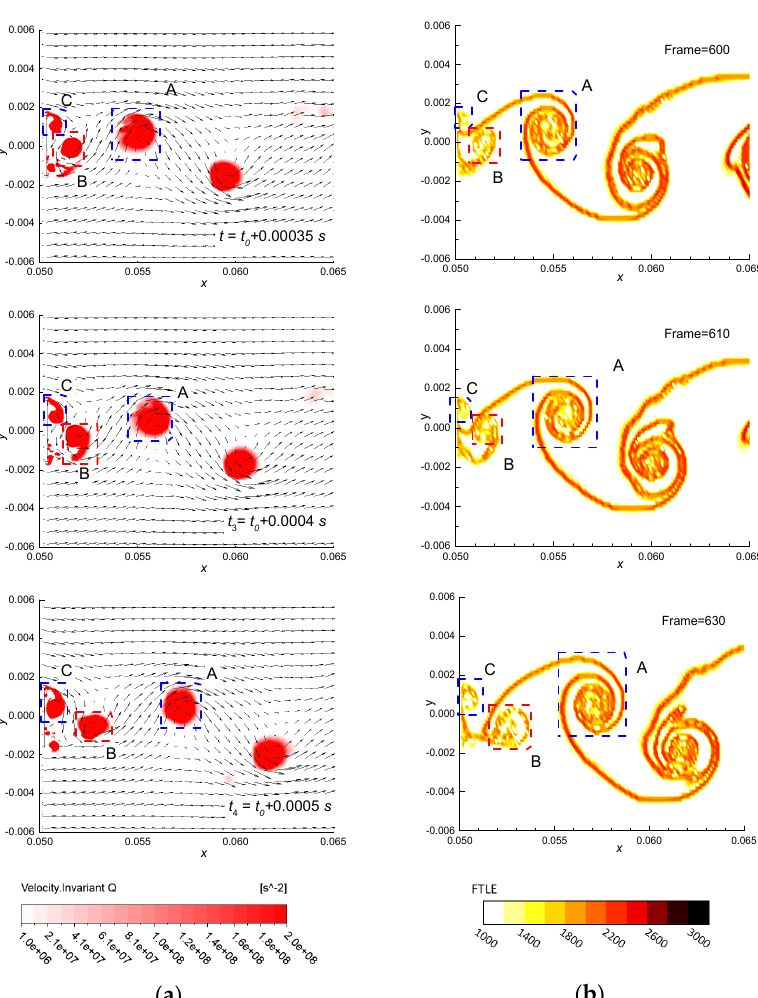
Figure 9. Plot for free cavitation conditions ( σ / σ i = 1.3) at five correlative instants of time from top to bottom of: ( a ) the instantaneous Eulerian Q criterion superposed to the instantaneous velocity; ( b ) the backward finite-time Lyapunov exponent